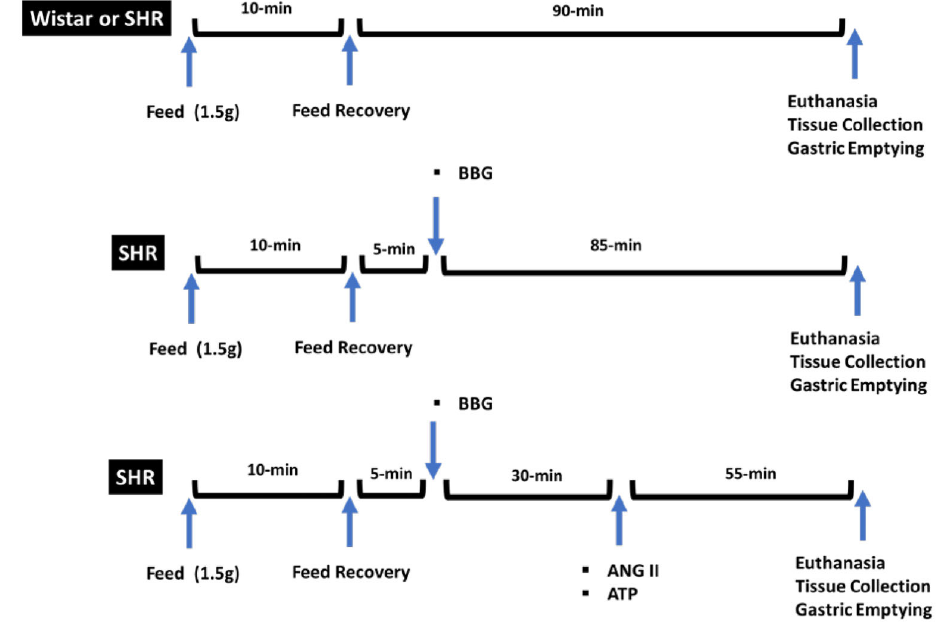
Figure 1. Experimental design. SHR: spontaneously hypertensive rat; BBG: Brilliant Blue G; ANG II: angiotensin II; ATP: adenosine